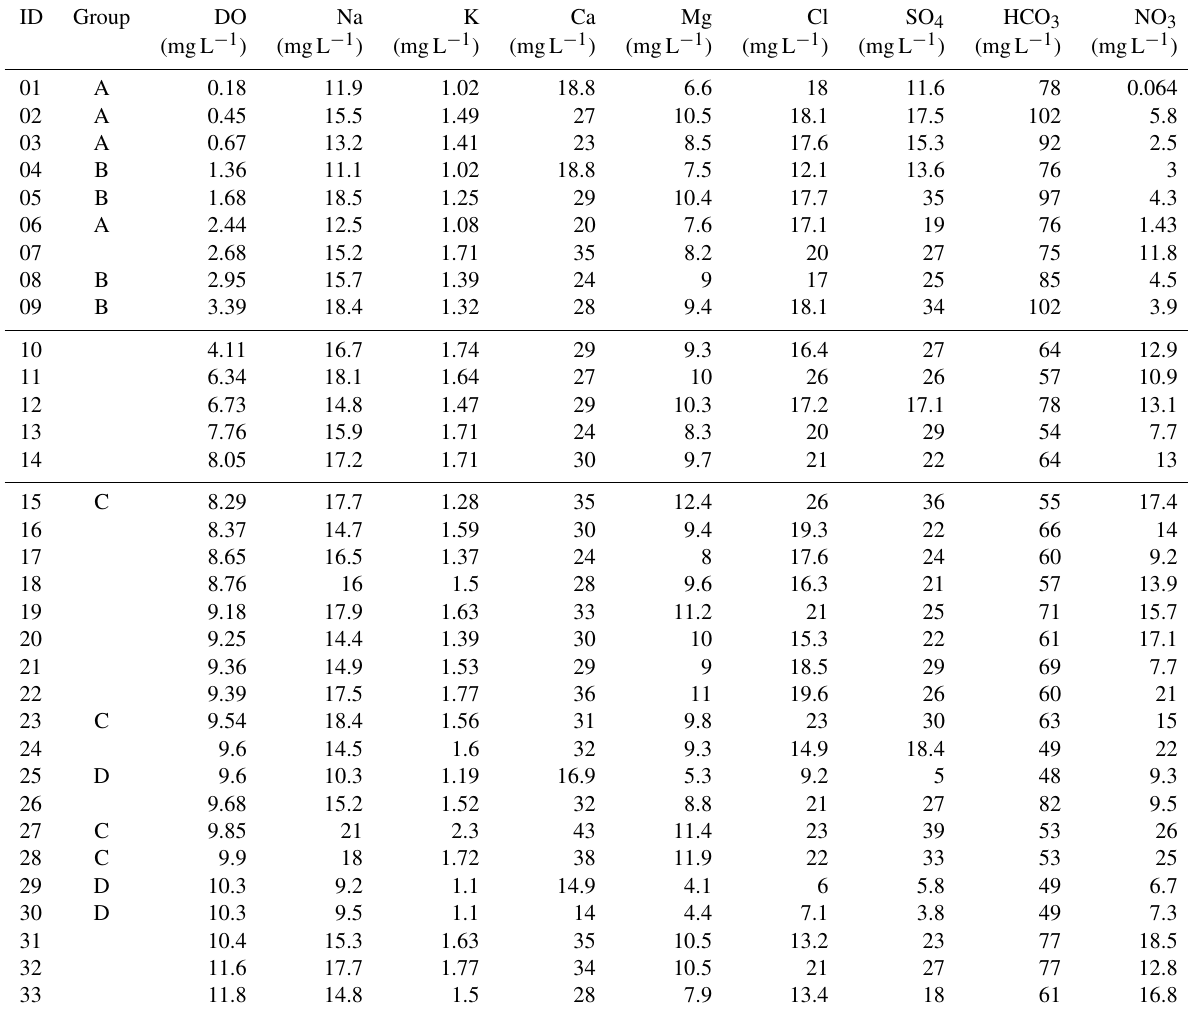
Table 2. Major ion chemistry of water